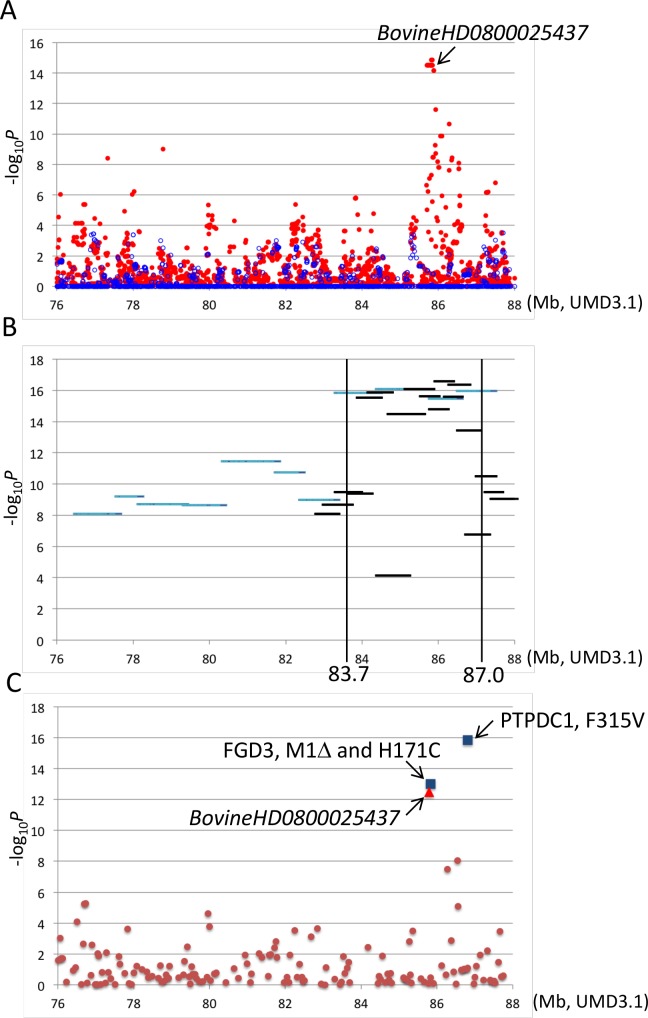
Association analyses using imputed BovineHD genotypes (A), segments of the identical-by-descent (IBD) Q haplotype (B), and candidate causative variations (C).Association with carcass weight was analyzed by a variance component approach using EMMAX software [39] with adjustments for age, slaughterhouse, and year as covariates and fixed effects. (A) Red and blue dots represent p values of imputed BovineHD genotypes in–log10 scale before and after conditioning, respectively. A conditioned analysis was performed by including an imputed genotype of BovineHD0800025437 as a covariate in the model. (B) Light blue and black lines represent p values of approximately 1-Mb and 500-kb Q haplotypes in–log10 scale, respectively. (C) Brown dots, a red triangle, and blue squares represent p values of Bovine50K genotypes, experimentally validated BovineHD0800025437 genotype, and the genotypes of candidate causative variations in–log10 scale, respectively.